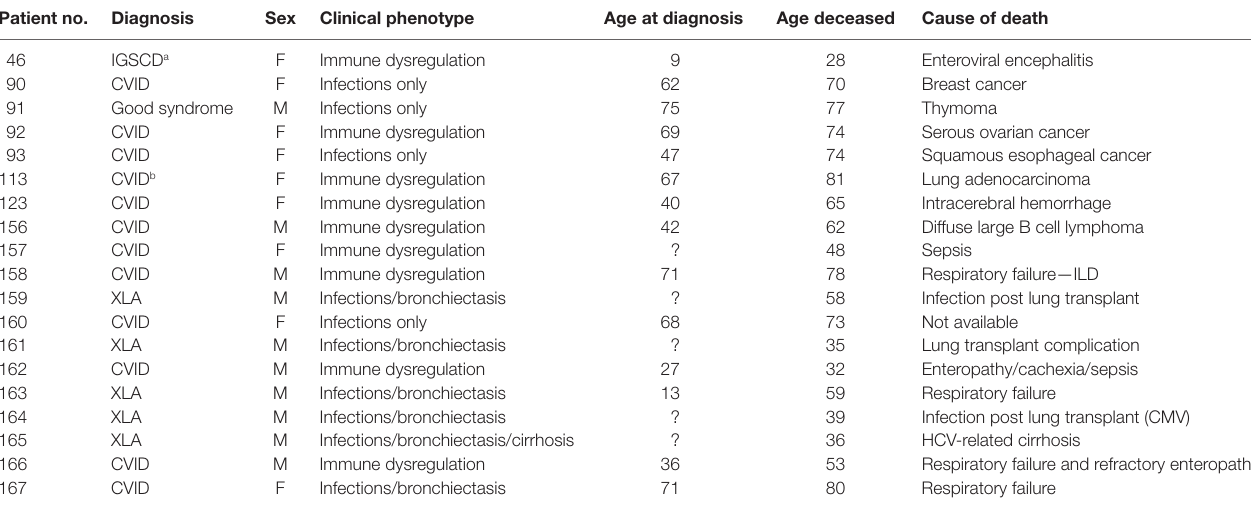
TaBle 3 | Causes of death among antibody deficient patients in Victoria (2000–2017). Patient no.